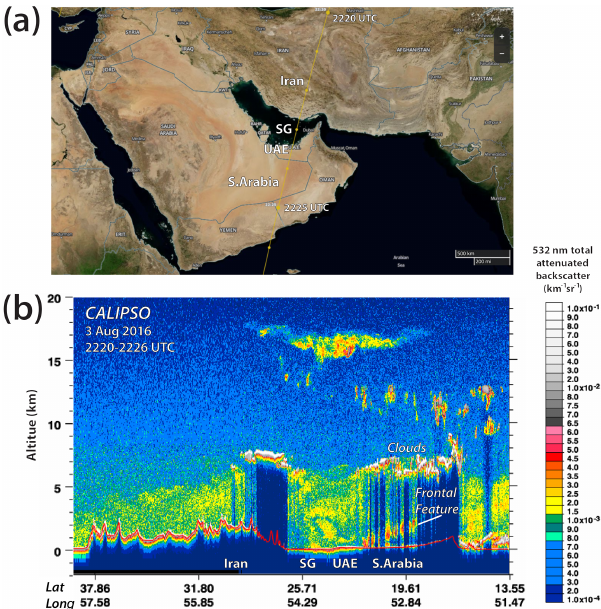
Figure 7. (a) CALIPSO ground track (NASA Worldview) and (b) CALIOP 532nm total attenuated backscatter cross section for 3 August 2016, ∼ 22:20–22:26UTC (within ∼ 15min of CATS). The same dust frontal feature noted in Fig. 6 is present near the southern UAE border with Saudi